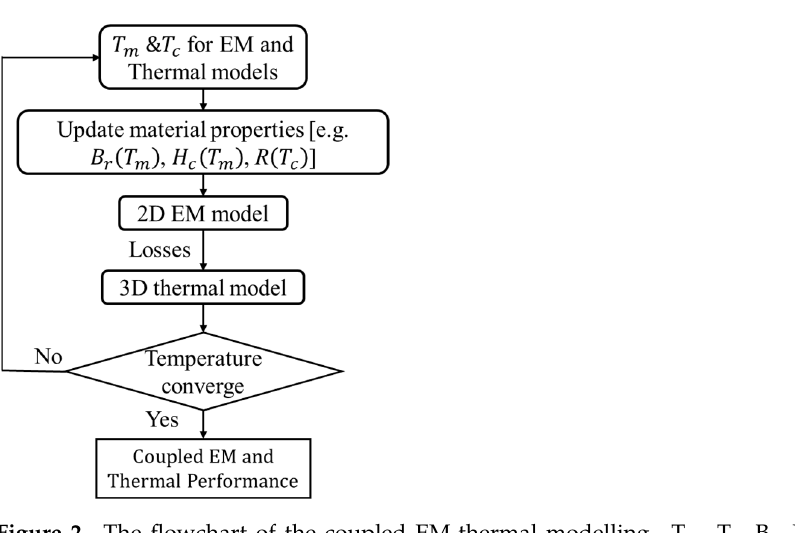
Table 1. General parameters of the investigated SPM